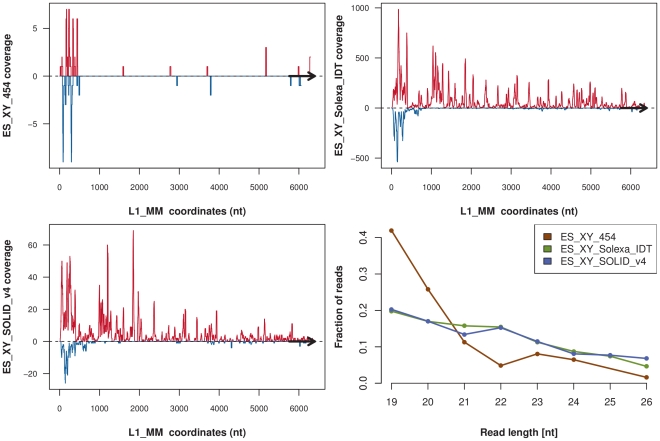
Reads coverage of L1 consensus sequence.The reads with a size of 19–26 nt were aligned on the L1_MM consensus sequence extracted from Repbase. The coverage from the ES_XY_Solexa_IDT, ES_XY_454 and ES_XY_SOLiD_v4 libraries, on the sense orientation is represented in red, whereas the coverage in antisense orientation is represented in blue. The size distribution of the reads aligned on the L1_MM consensus is shown for the three libraries.